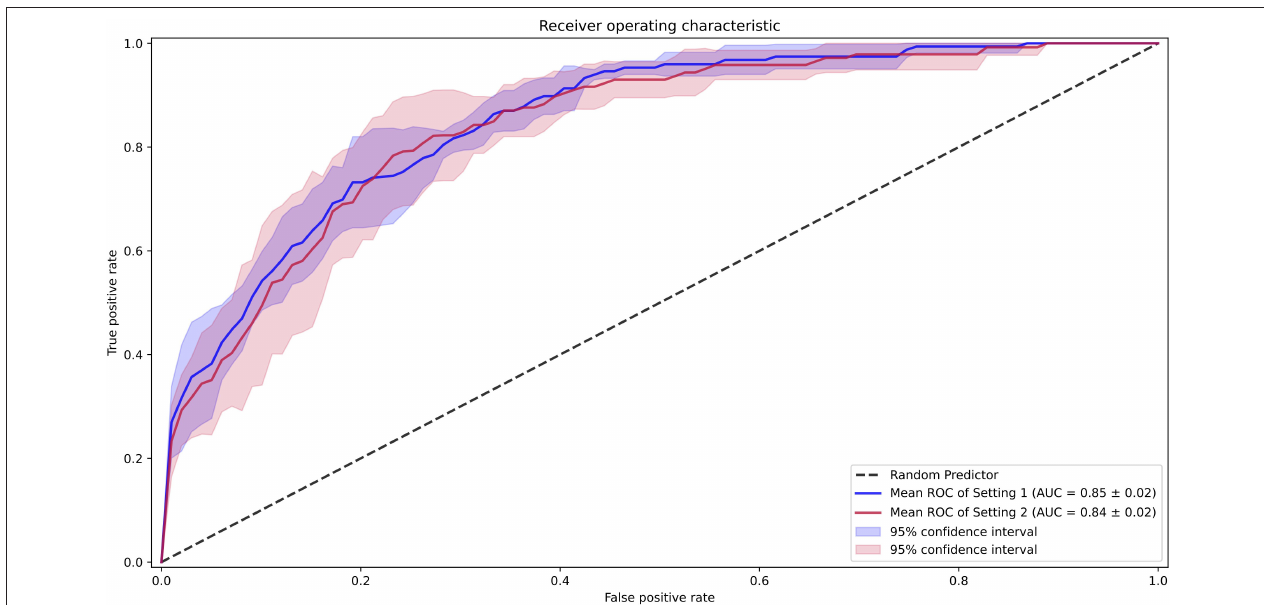
FIGURE 4 | Receiver operating characteristic curves for the performance of the AI model. Setting 1 for with supraventricular ectopy (SVE) events and Setting 2 for without SVE